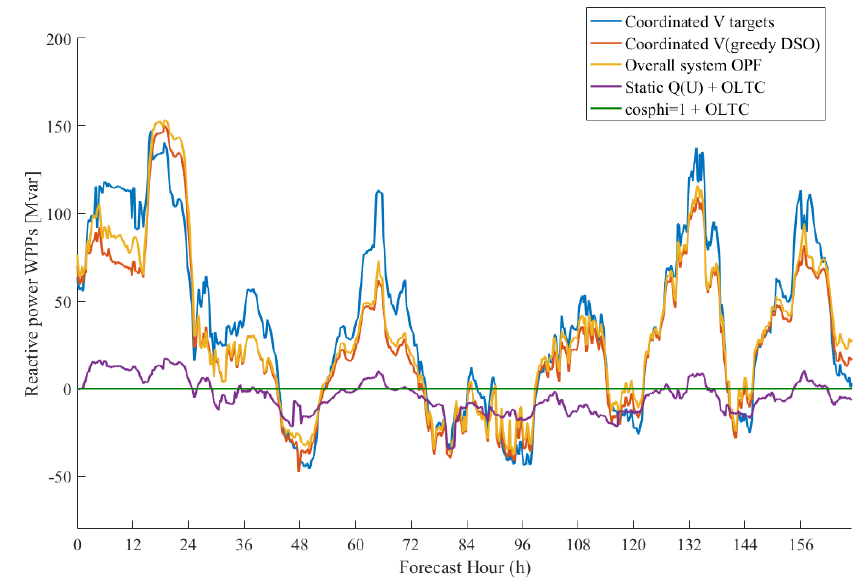
Figure 18. Reactive power output of controlled wind farms.